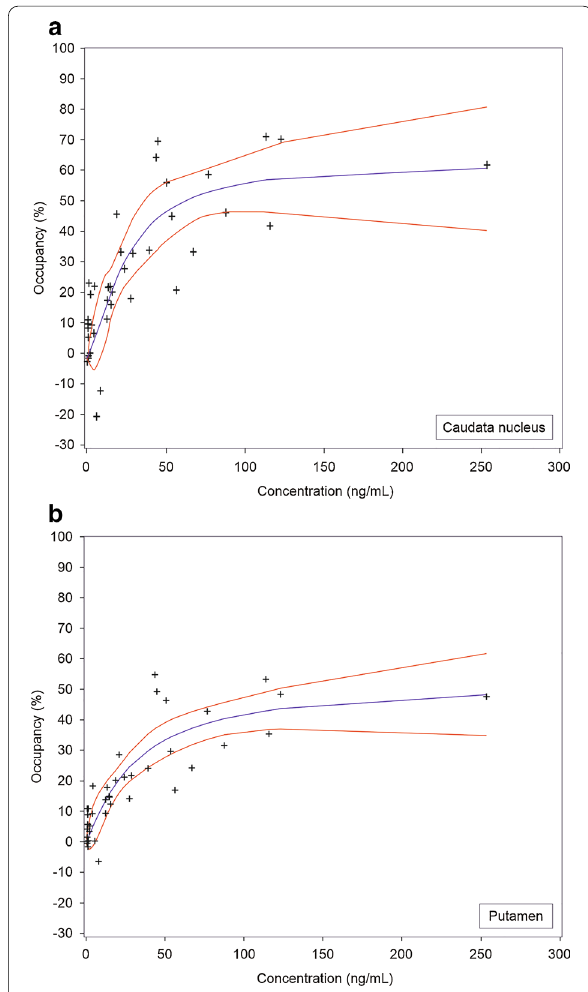
Fig. 4 The relationship between ORM-12741 plasma levels and α 2C -adrenoceptor occupancy in human a caudate nucleus and b in putamen. The blue line represents binding hyperboles derived from nonlinear regression analysis with a sigmoidal maximum possible effect model. The red lines represent 95% confidence intervals. Concentrations of ORM-12741 in plasma represent mean values of samples collected at the start and end of the PET scan. Each data point represents an individual occupancy value at one time